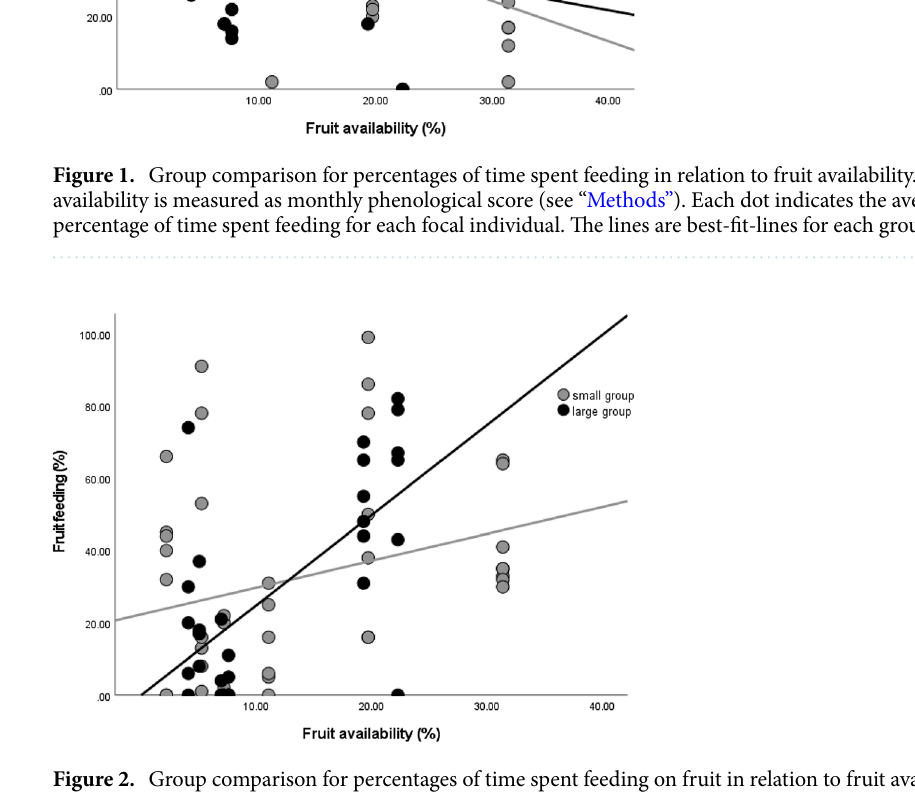
Figure 2. Group comparison for percentages of time spent feeding on fruit in relation to fruit availability. Fruit availability is measured as monthly phenological score (see “Methods”). Each dot indicates the average monthly percentage of time spent feeding on fruit for each focal individual. The lines are best-fit-lines for each group data